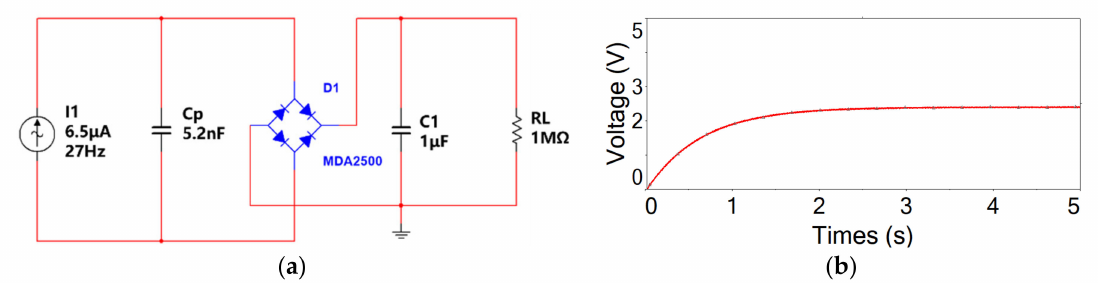
Figure 9. Simulation results of the doubly clamped flexible energy harvester with a standard electric circuit: ( a ) standard bridge electric circuit for the piezoelectric energy harvester; ( b ) output voltage across the load resistor.